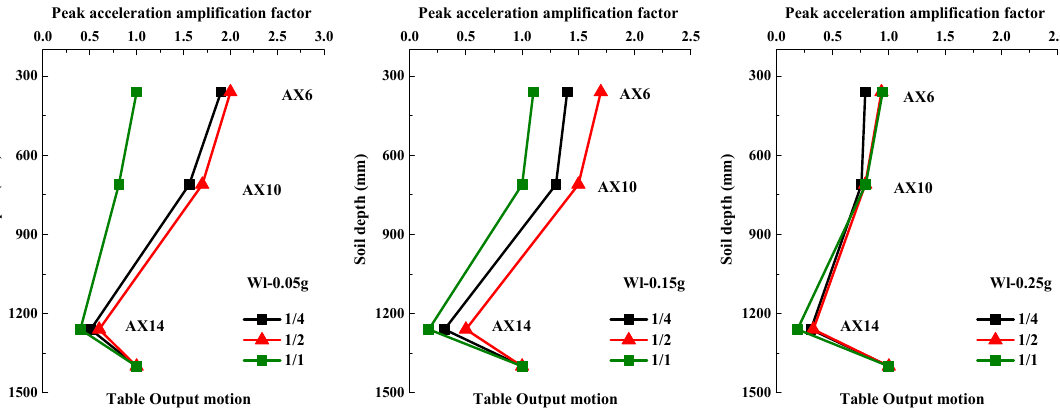
Figure 11. The peak acceleration amplification ratio of the model soil under scaled Wolong records.